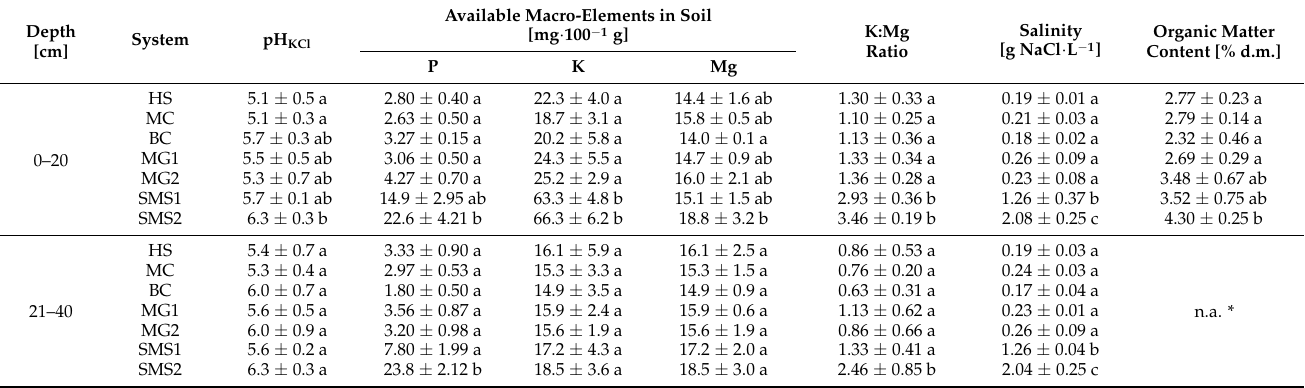
Table 3. Soil parameters measured in two layers depending on floor management systems in the second season of the